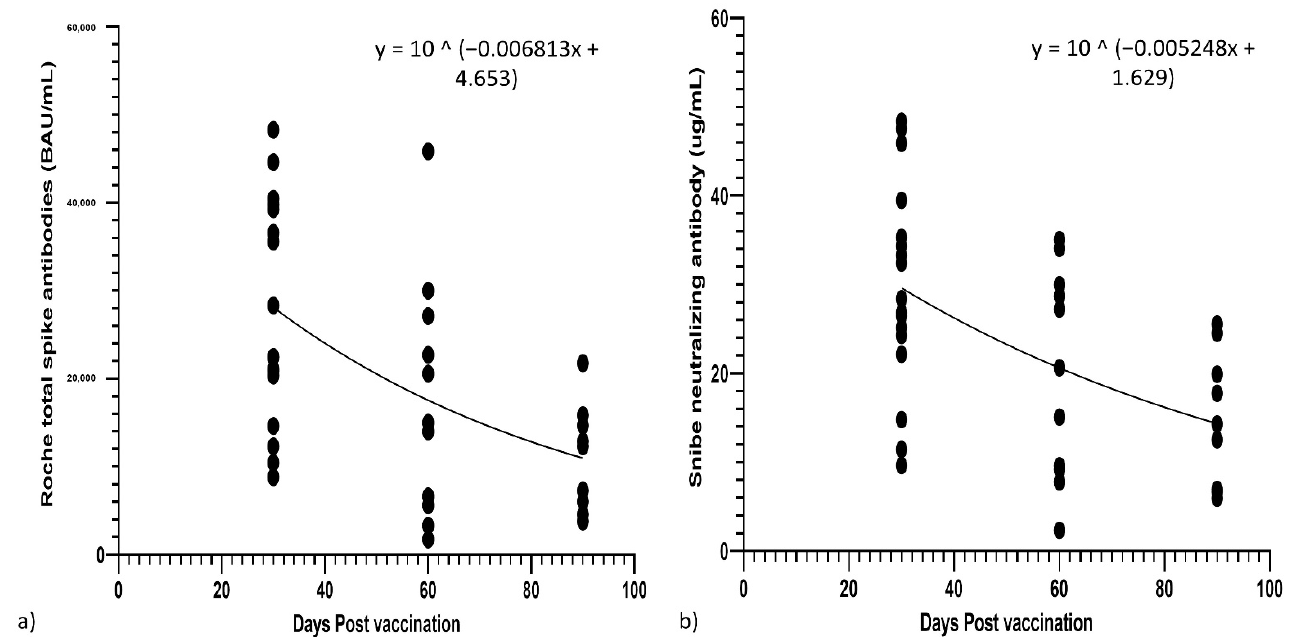
Figure 4. Non linear regression of ( a ) Roche total spike and ( b ) Snibe neutralizing antibodies from their peak at 30 days post-booster vaccination.